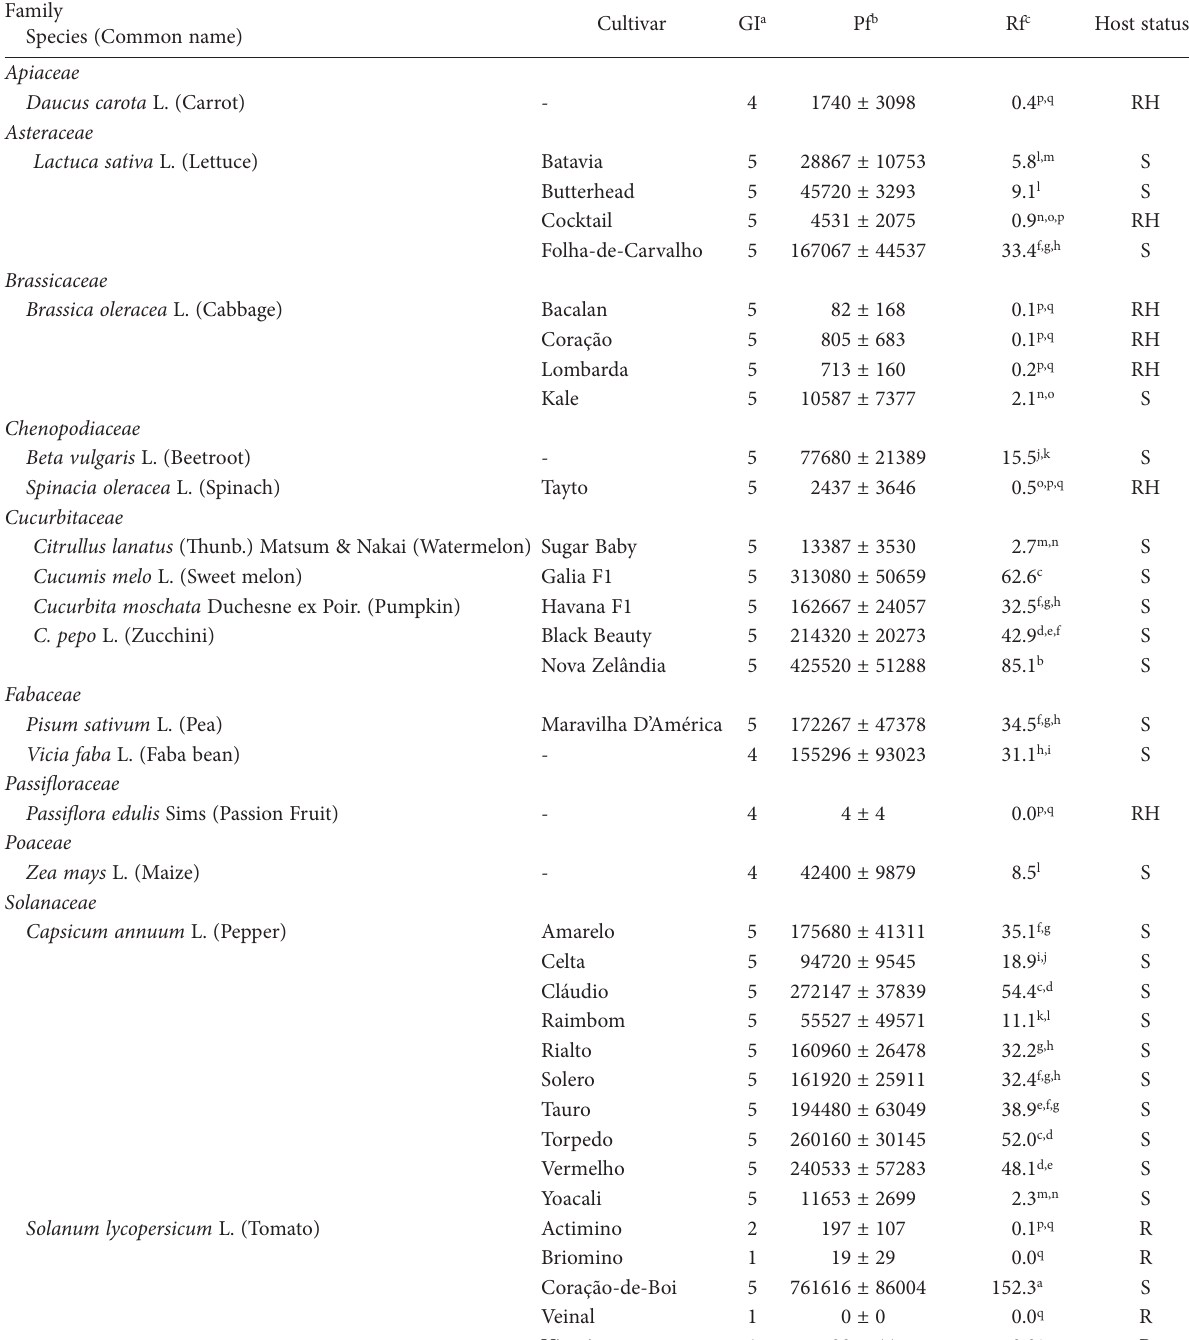
Table 1. Means of GI, Pf and Rf (see footnote) for different cultivated plants inoculated with the root-knot nematode Meloidogyne luci, 60 d after inoculation with 5000 eggs/plant in a pot assay conducted in a growth chamber (23 ± 2°C, 12 h daily photoperiod, ±60% relative